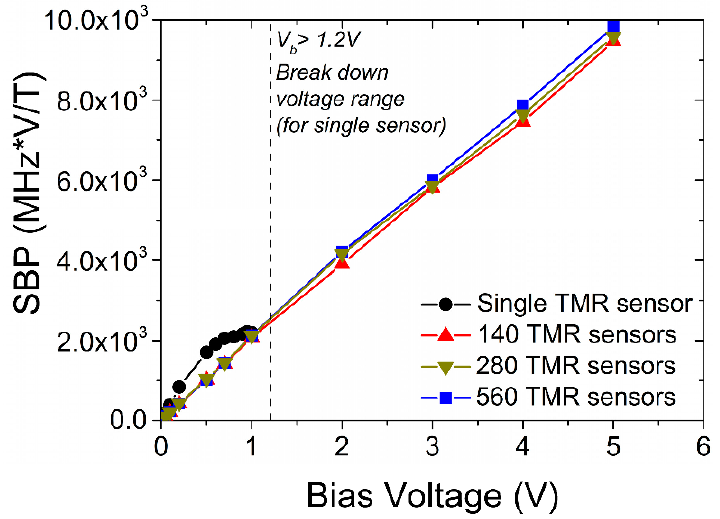
Figure 4. Bias voltage effect on sensitivity-bandwidth product of single and series-connected sensors.